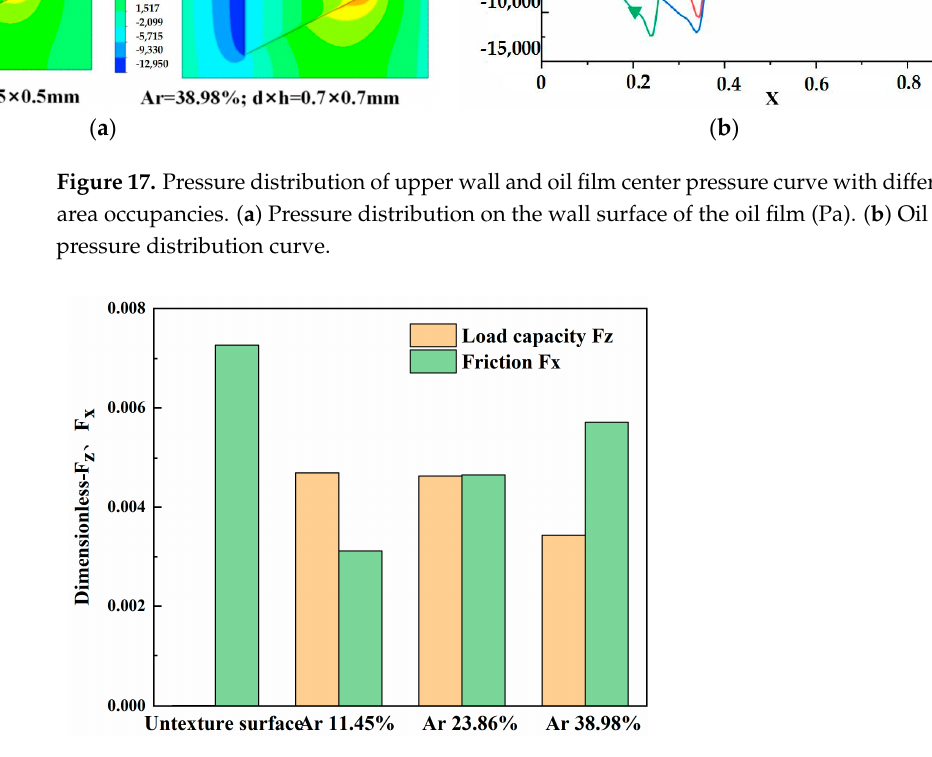
Figure 19. Wear mechanism diagram. ( a ) Texture only. ( b ) Texture composite nitriding. 5. Conclusions In summary, a nitride–oxide layer composite texture was formed on the surface of 4Cr10Si2Mo by laser processing and salt bath nitriding and reoxidation treatment. Tribological wear tests and simulation analysis investigated the tribological properties of